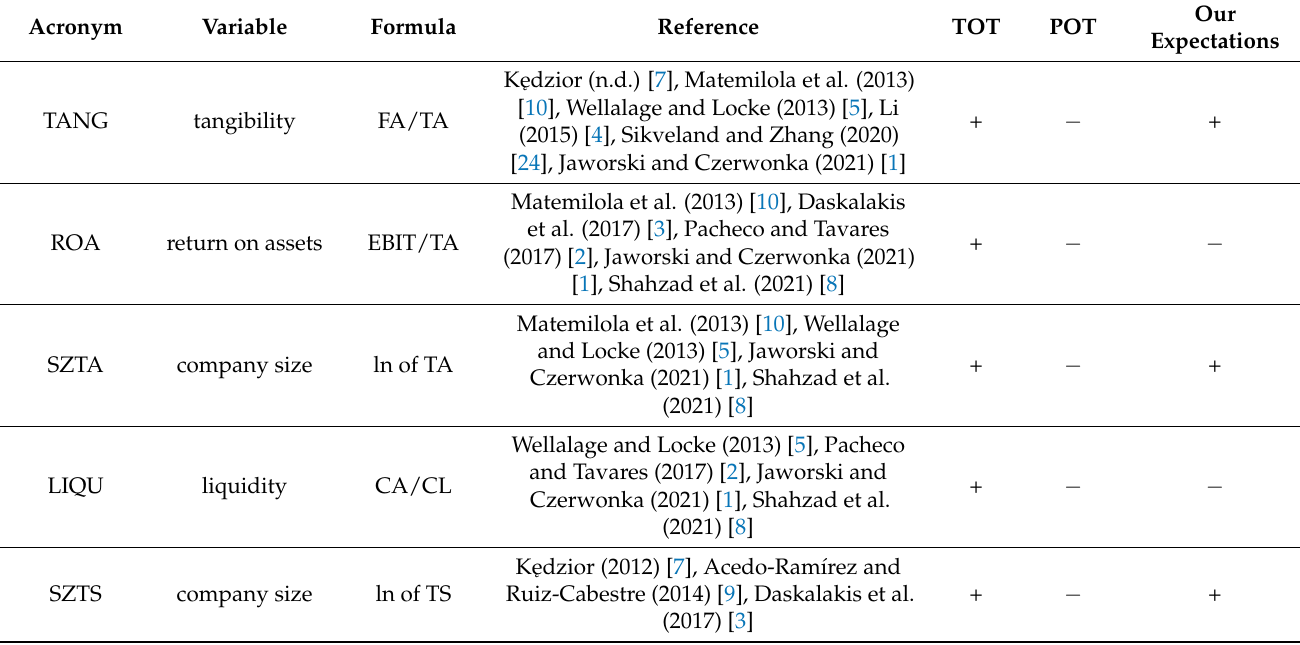
Table 3. Independent variables and their impact according to the capital structure